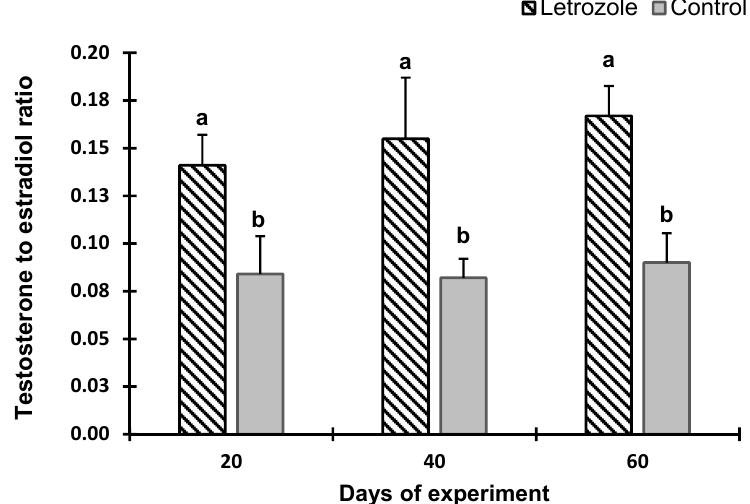
Figure 4. Testosterone to estradiol ratio in Markhoz bucks treated letrozole (0.25 mg/kg BW/wk) or control. Error bars indicate standard deviation. a,b Statistically significant differences (p<0.05) between the groups.